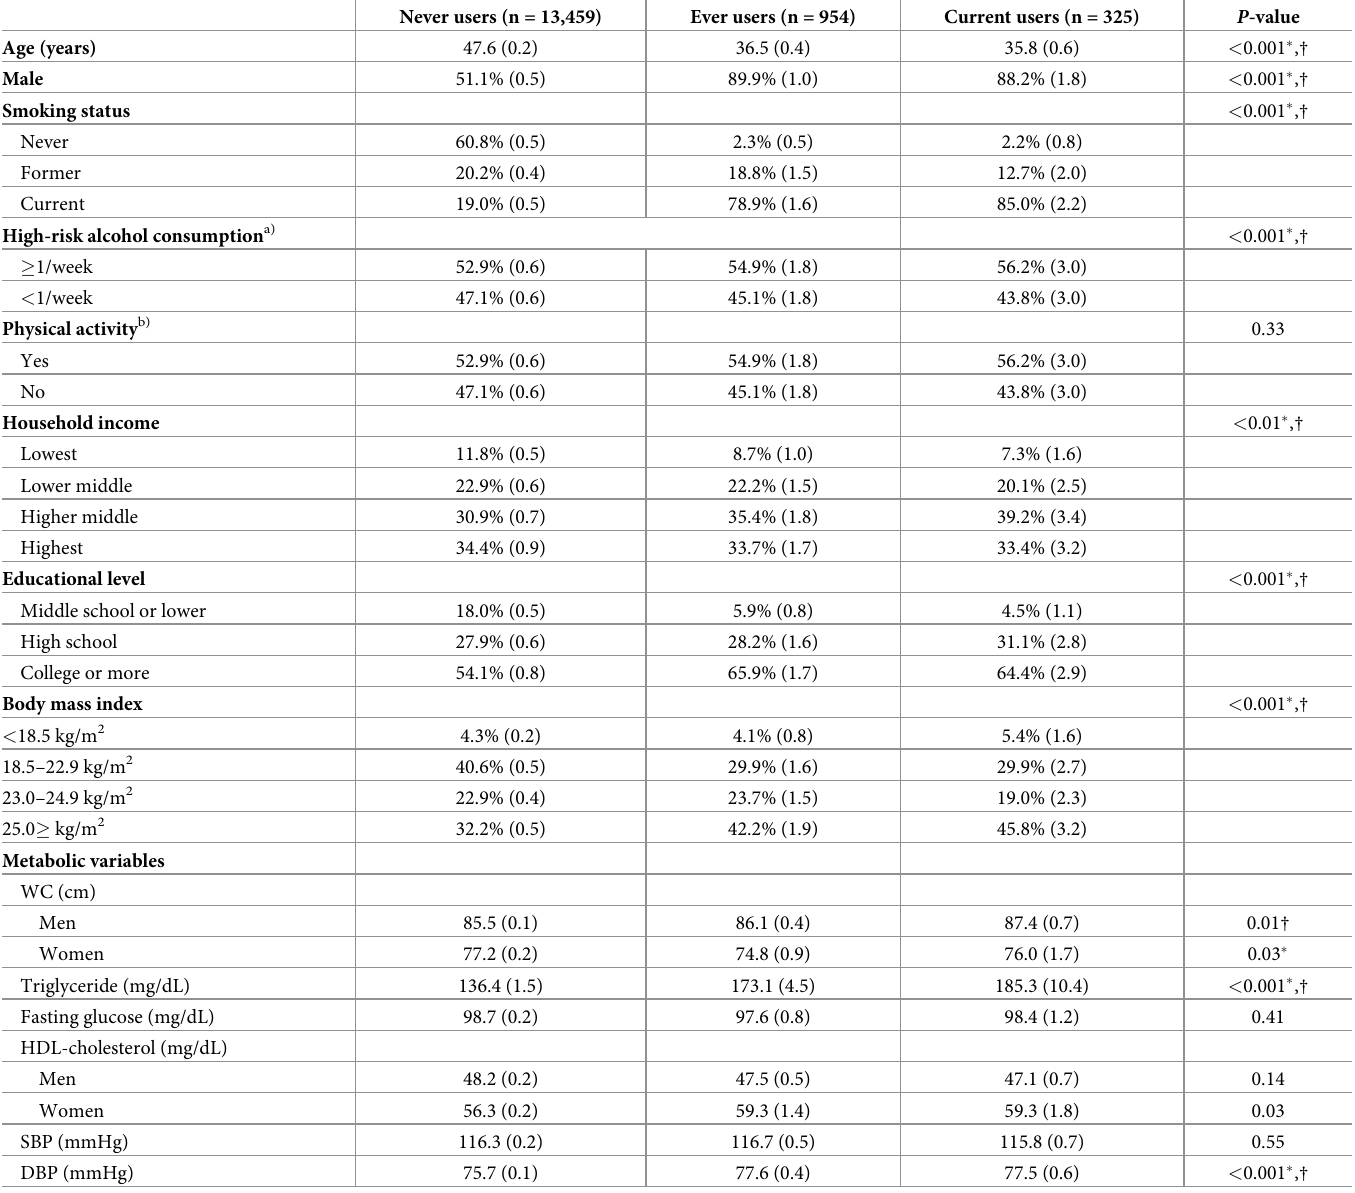
Table 1. Characteristics of the study participants according to electronic cigarette exposure (N =